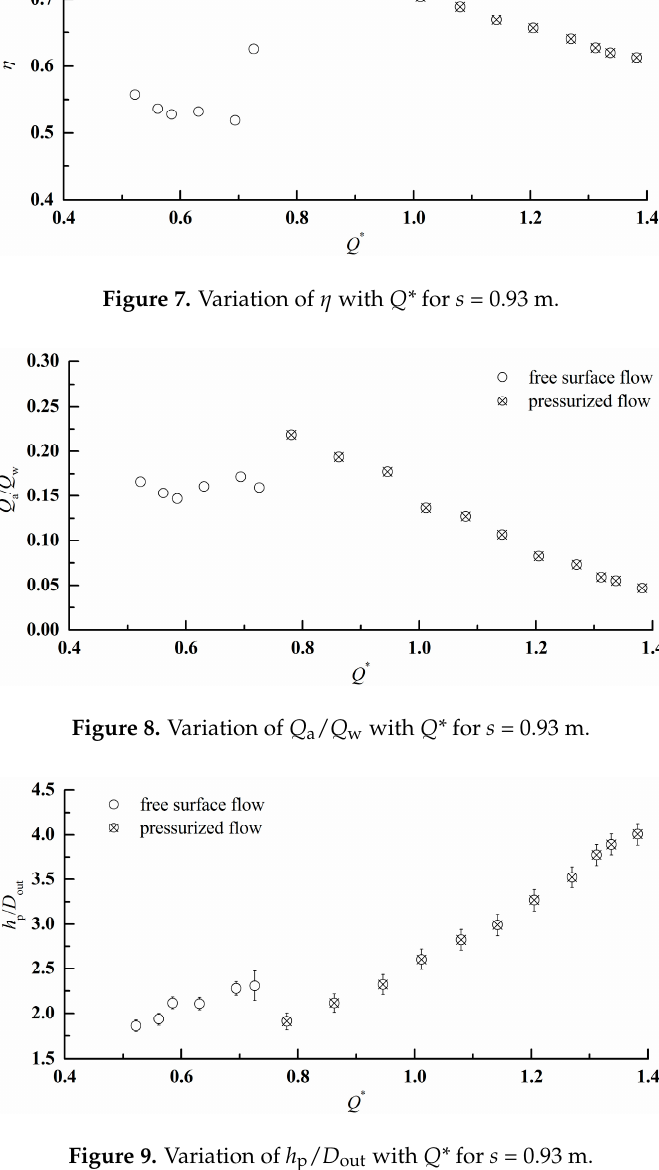
Figure 9. Variation of h p / D out with Q* for s = 0.93 m.